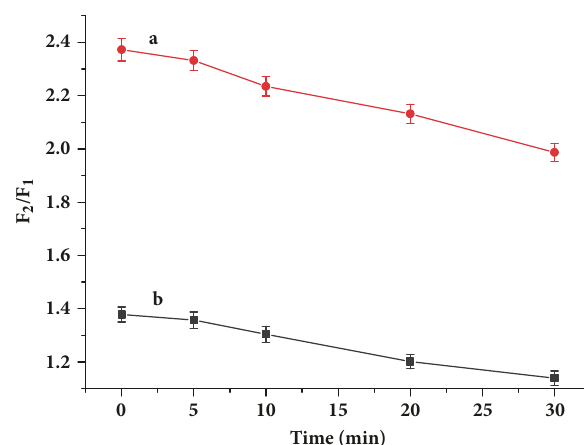
Figure 2: Fluorescence quenching efficiency of Cu 2+ (a) and fluorescencerecovering efficiency of GSH (b) at different pH values. Figure 3: Time-dependent fluorescence recovering efficiency of 200 𝜇 M GSH (a) and 40 𝜇 M GSH (b).